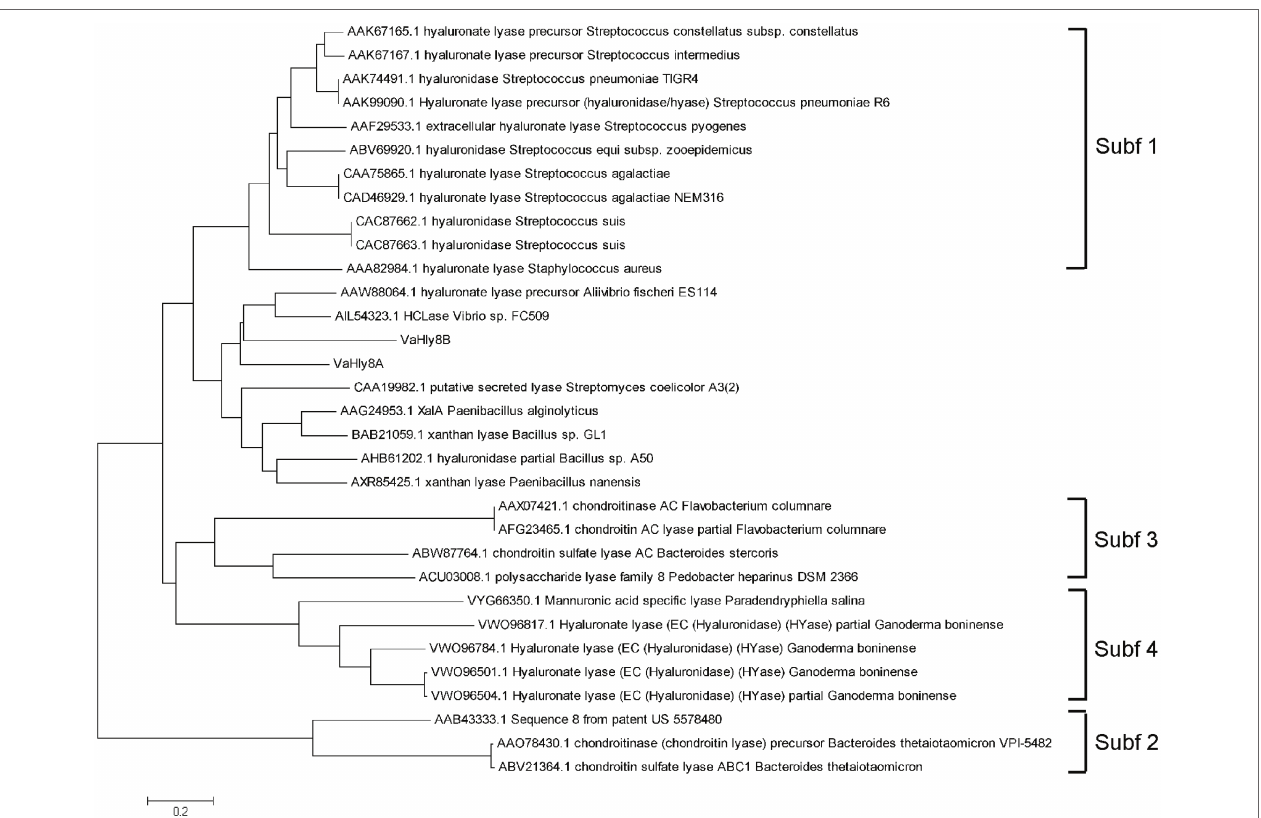
FIGURE 4 | Phylogenetic tree of VaHly8A, VaHly8B and other enzymes of the PL8 family. The phylogenetic tree was constructed by MEGA X using the neighbor- joining